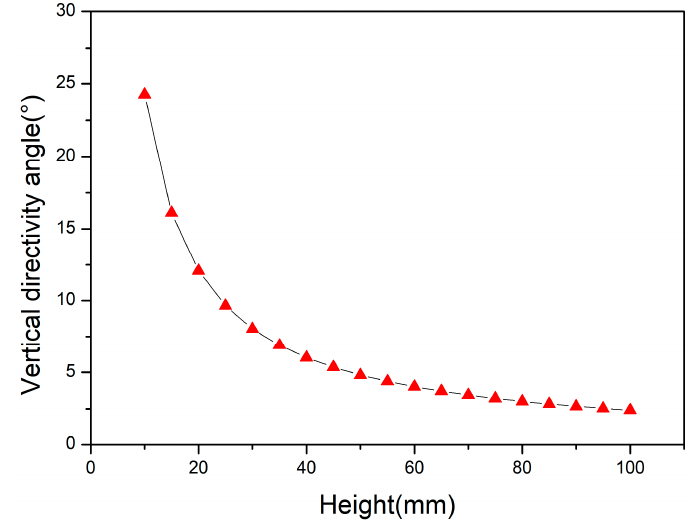
Figure 4. The variation of the directivity angle of the vertical direction with the vertical direction.